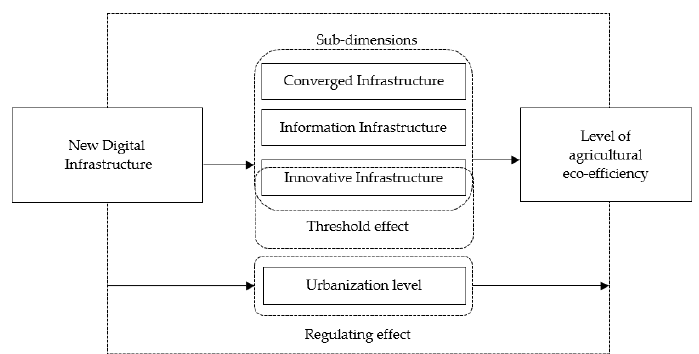
Figure 1. Mechanism of the role of new digital infrastructure on the level of AEE.